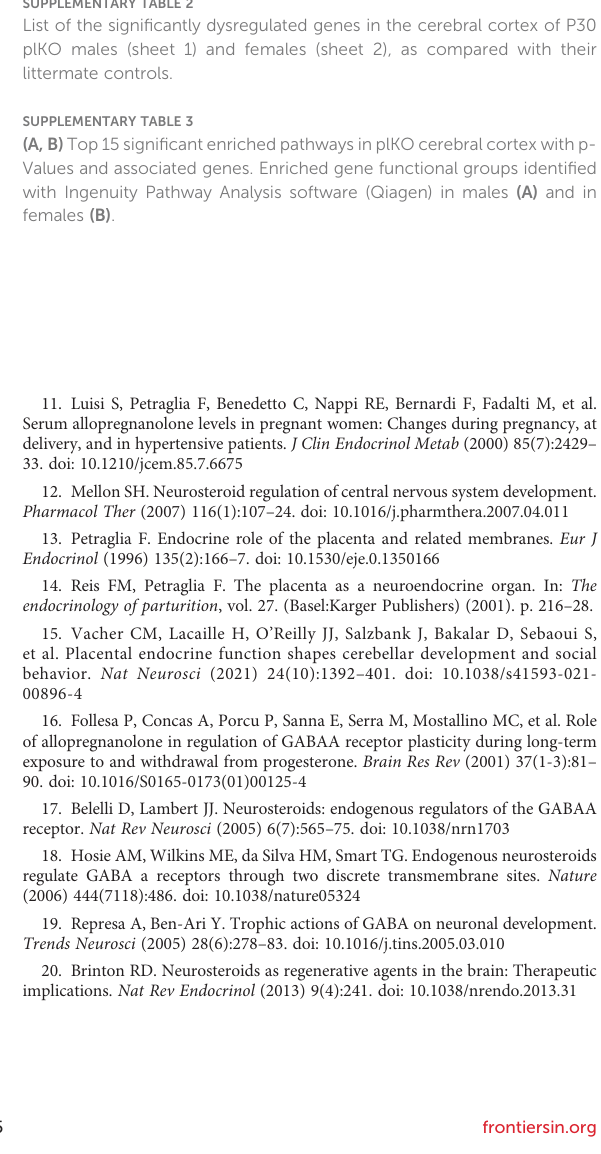
SUPPLEMENTARY FIGURE 4 Body weight in the Ctrl and plKO males (A) and females (B) across early postnatal development and adulthood. Data presented as mean ± SEM. Two-way age by genotype repeated measures ANOVA with Sidak ’ s post- hoc comparison test. Main effect of age in males and females: p<0.0001.